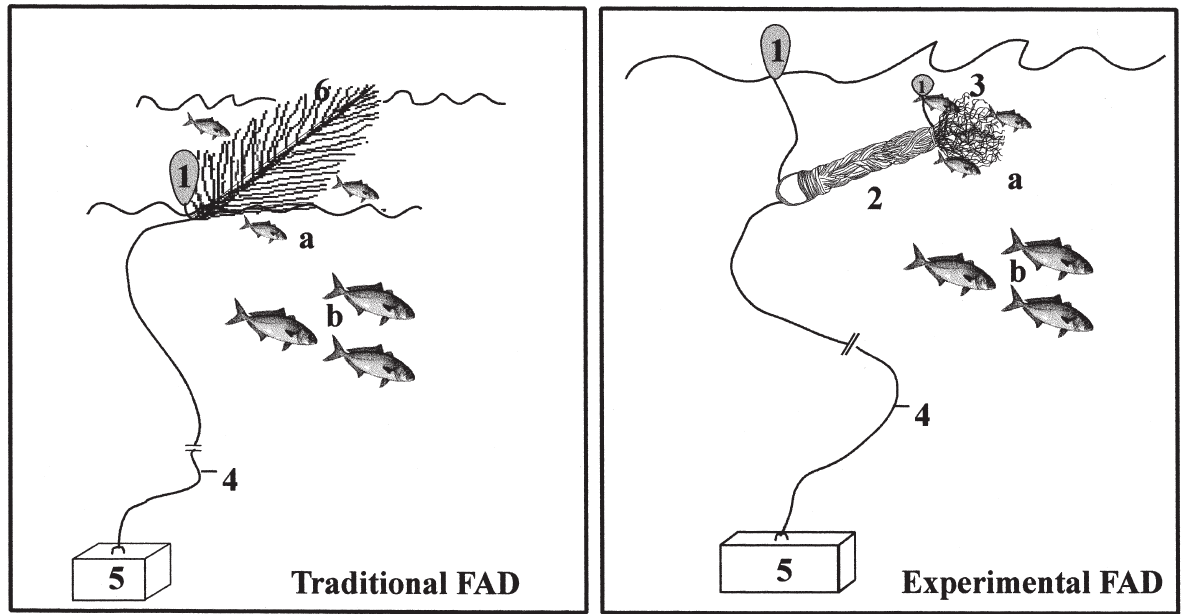
F IG . 2. – Schematic representation of the components of traditional and experimental FADs: 1 = signalling buoy; 2 = 2-metre-long buoyant multifilament polypropylene rope; 3 = one-metre-long frayed tuft of FAD; 4 = rope joining FAD to anchor; 5 = weight of 30-40 kg; 6 = 2-3 metre-long palm leaf. a = greater amberjack with total length < 10 cm; b = greater amberjack with total length between 15 and 25